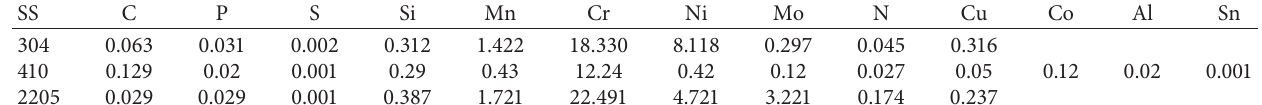
Table 1: Elemental compositions (wt. %) of 3 stainless steel types (Fe